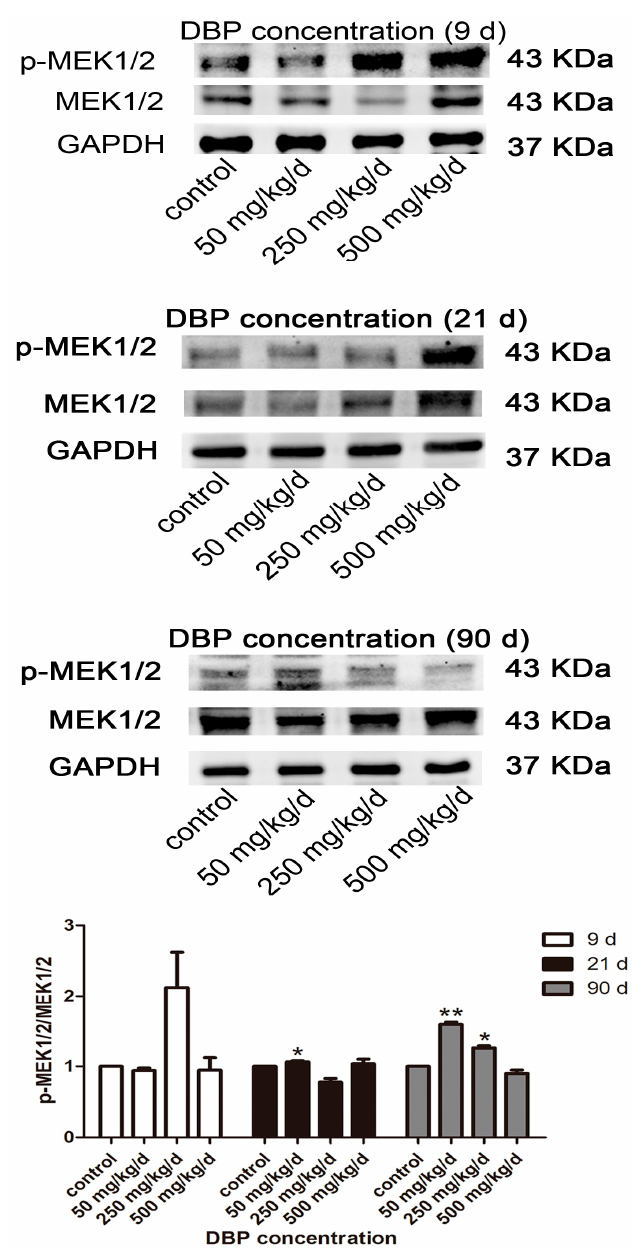
Figure 4. DBP induces the activation of mitogen-activated protein kinase (MAPK)-associated proliferation protein in testicular tissue. The protein levels of mitogen-activated protein kinase kinases1/2 (MEK1/2) and phospho-MEK1/2 (p-MEK1/2) in testicular tissue treated with various concentration of DBP were measured by Western blot. The expression levels were quantified with ImageJ (lower panel; n = 3). GAPDH was run as an internal control. Results are expressed as means ± S.D. ** p < 0.01; * p < 0.05. Scale bar = 100 μ m.